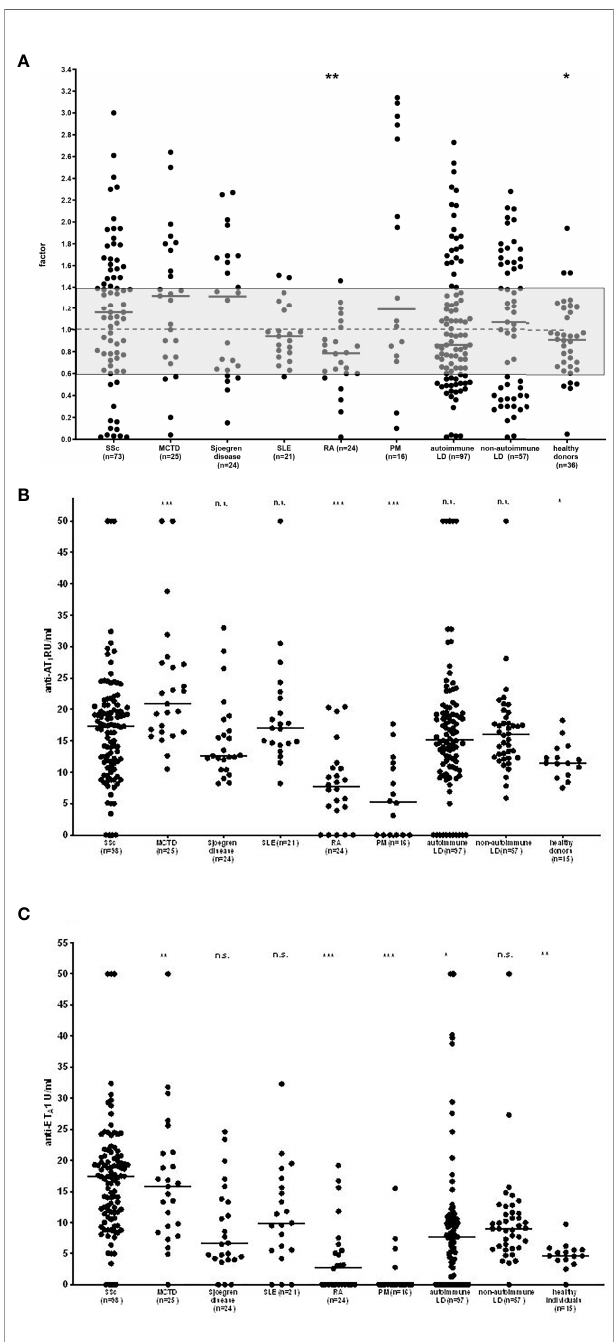
FIGURE 1 | Reactivity of functionally active antibodies to the AT 1 R measured by a luminometric bioassay (A) and antibodies to AT 1 R (B) and ET A 1 (C) measured by ELISA in patients with systemic sclerosis (SSc) as compared to healthy controls and patients with other collagen disorders as well as further autoimmune and non-autoimmune diseases. For the functional assay, individual values are given re fl ecting a factor calculated with the mean of healthy individuals. The grey zone indicates the normal range. MCTD-mixed connective tissue disease, SLE-systemic lupus erythematosus, RA-rheumatoid arthritis, PM-polymyalgia rheumatica, LD-liver diseases. p-values for SSc as compared to other disorders are given: n.s., not signi fi cant; *p < 0.05; **p < 0.01; ***p < 0.001; -